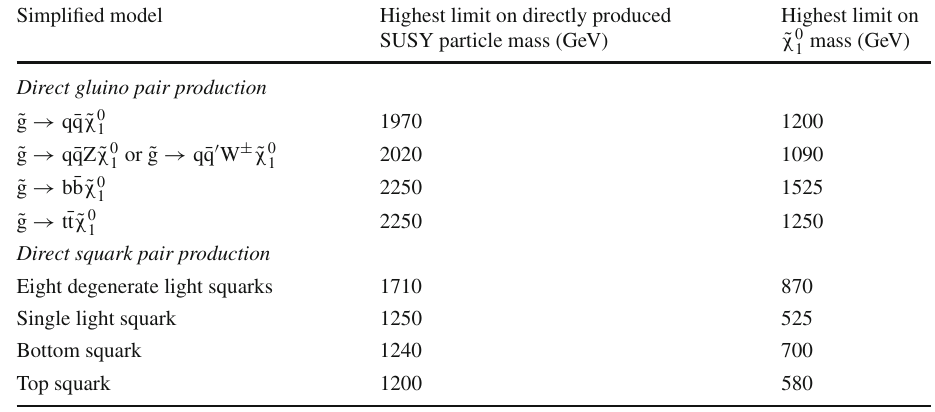
SUSY particle mass (GeV)